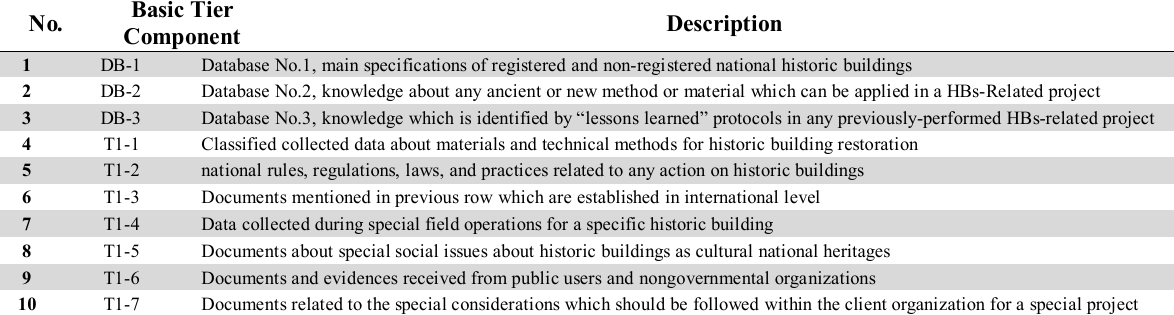
Description of the terms indicated in Basic Tier block diagram (Fig. 2)